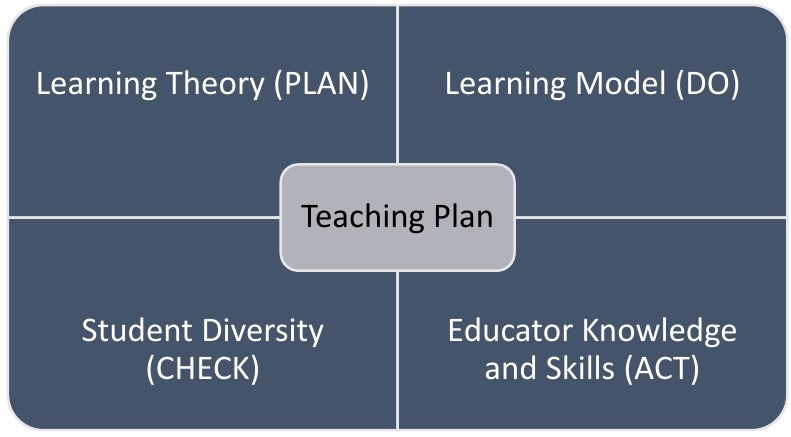
Figure 1. Conceptual framework.